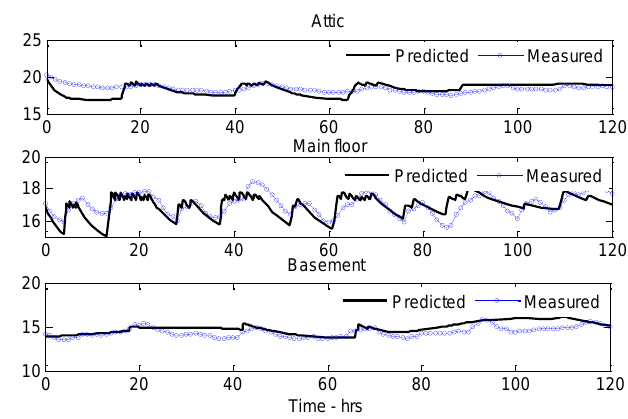
Figure 5: Variation of inside air temperature in the at- tic, main floor and basement in the multi- floor model [ 0